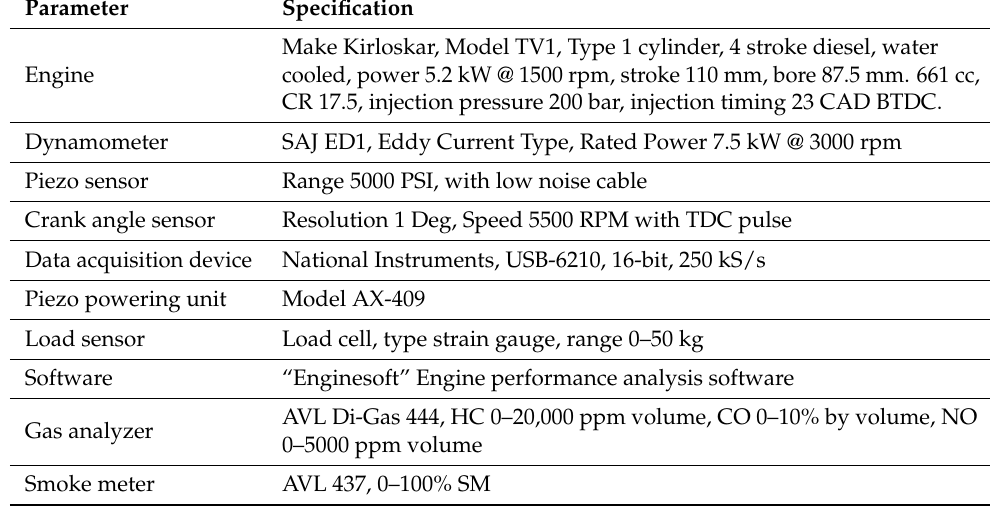
Table 5. Technical details of the test